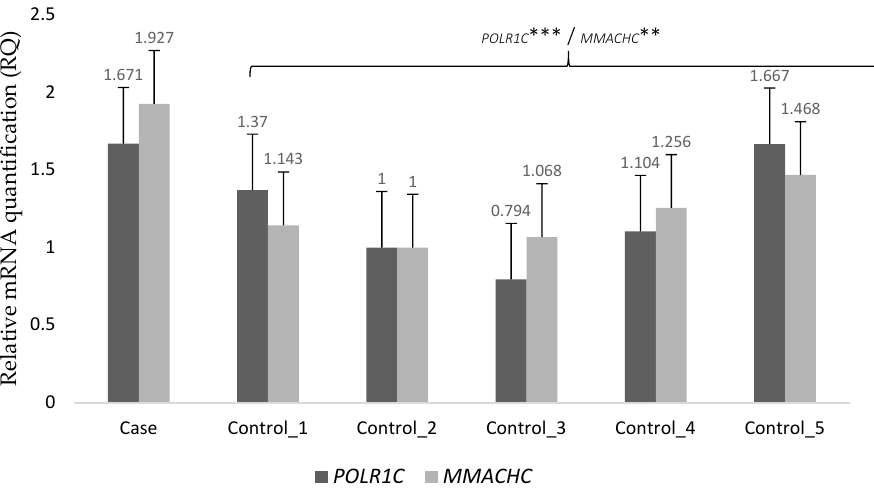
Figure 2. RT–PCR analysis of mRNA expressions of POLR1C and MMACHC in the patient and the control. mRNA expression was determined by RT–PCR is calculated as a ratio relative to GAPDH and expressed relative to the controls. Error bars represent standard deviation (SD). ***, p < 0.0001; **, p < 0.01.